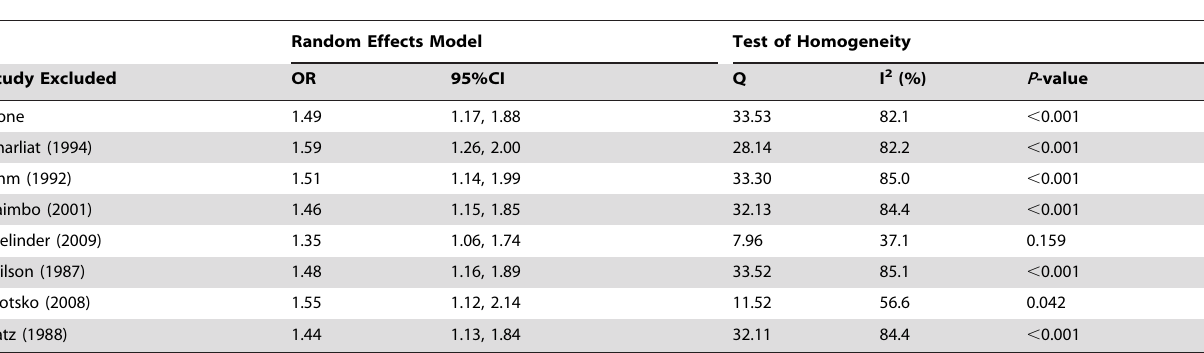
Table 3. Sensitivity analysis of case-control